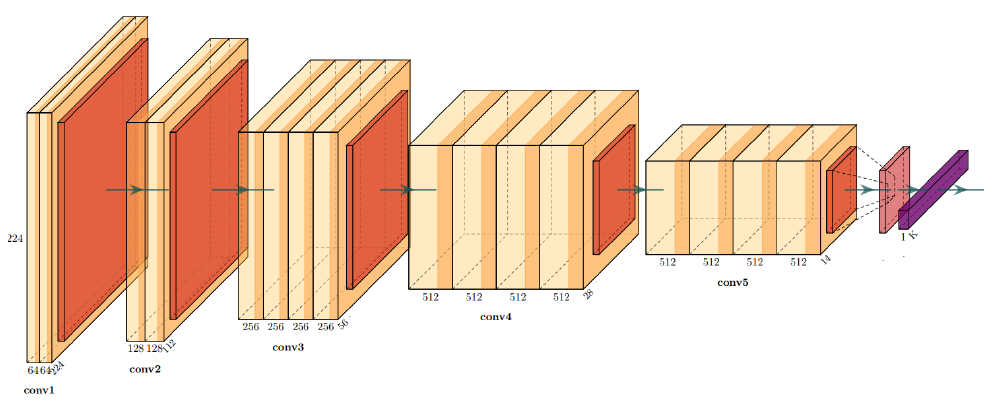
Figure 5. The architecture diagram of the VGG-Ear.